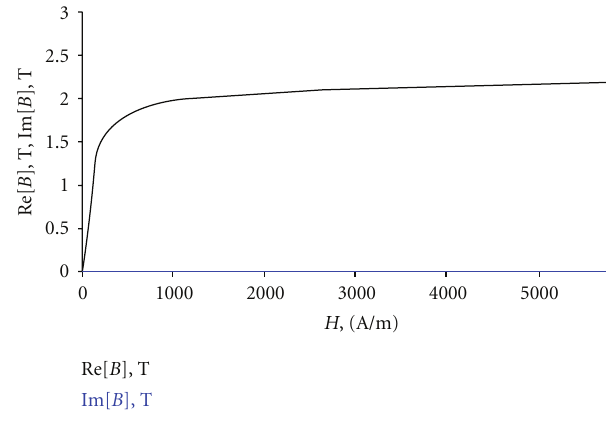
Figure 5: Rotor linear B-H relationship.